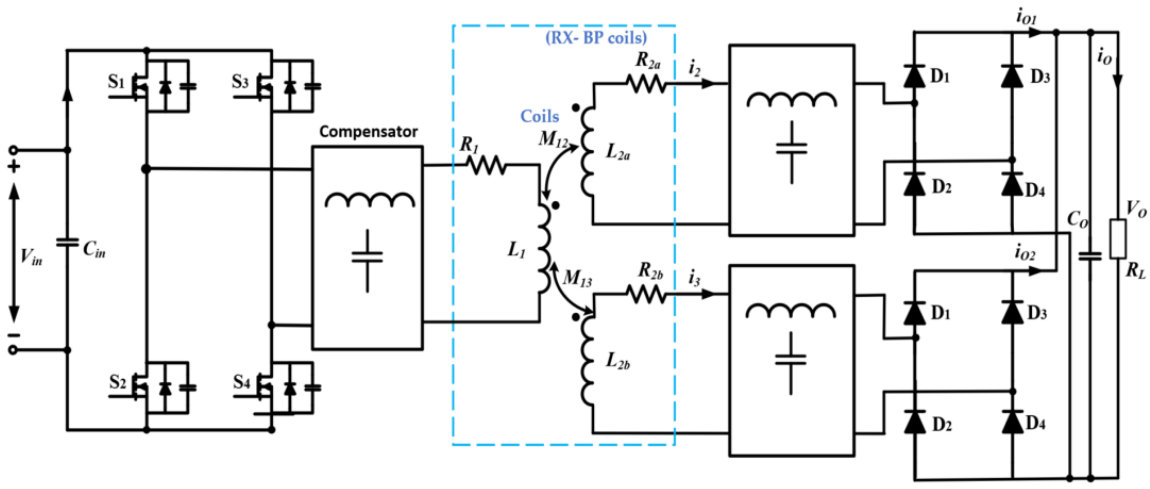
Figure 20. A typical dual-coil and dual-rectifier circuit architecture for a high-current IPT system. As shown in Figure 21, since the secondary current output is reduced by half of the output current, current double rectifiers and their modifications are used to deal with the high-current stress on rectifiers in high-current IPT systems [127,133–135]. In [127], a 10 kW 400 V/48 V IPT is proposed with an ICCDR structure to handle 200 A output current and achieves an overall efficiency of 94%. As summarized in Table 7, several studies on low-voltage/high-current IPT systems have been introduced in recent